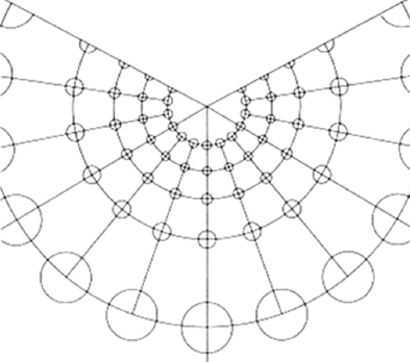
Fig. 13. The circular Tissot’s indicatrices of distortion in the Lambert conical conformal projection (Snyder, Voxland